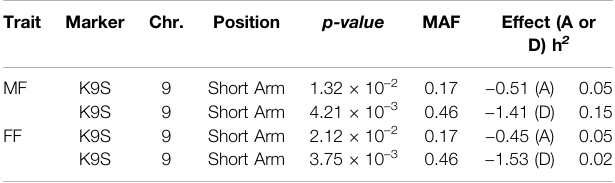
TABLE 2 | Signi fi cant marker-trait association for fl owering time. Male fl owering (MF), female fl owering (FF), knob in the short arm of chromosome 9 (K9S), p- value Bonferroni test, minor allele frequency (MAF), allele substitution model (A), dominance model (D), and heritability (h 2 ). Trait Marker